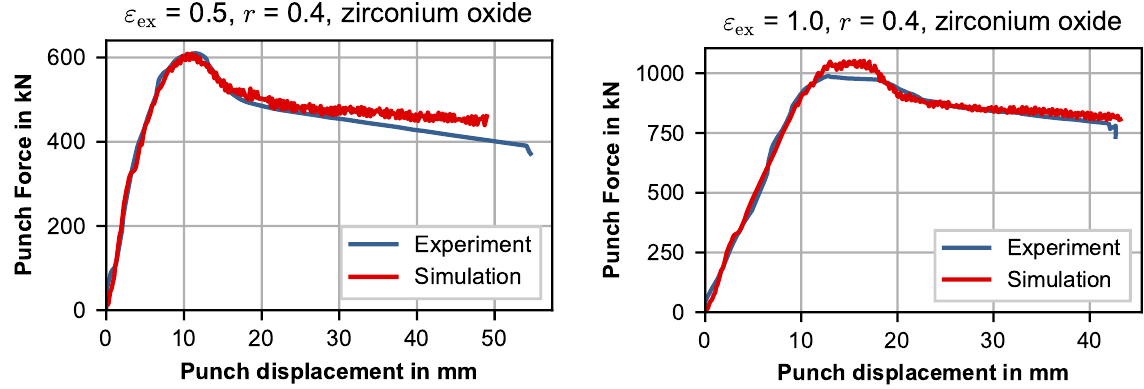
Figure 16. Punch force measured in experiments and obtained from simulation of forward rod extrusion with zirconium oxide core.